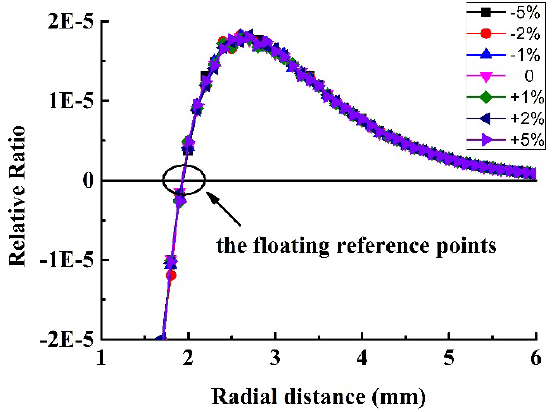
Fig. 7. The FRPs with light source drift errors with NP.